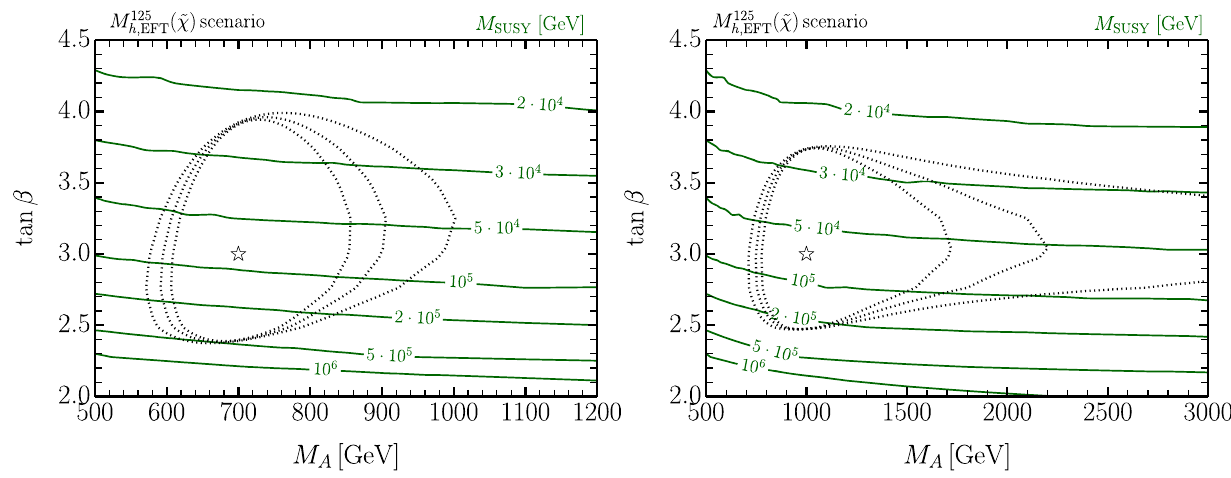
Fig. 13 Contours of the scalar fermion soft-SUSY breaking mass M SUSY in the ( M A , tan β ) parameter plane of the M 125 nario discussed in Fig.12, assuming that the point, indicated by a star, ( M , tan β) = ( 700GeV , 3 ) (left panel) or ( M A